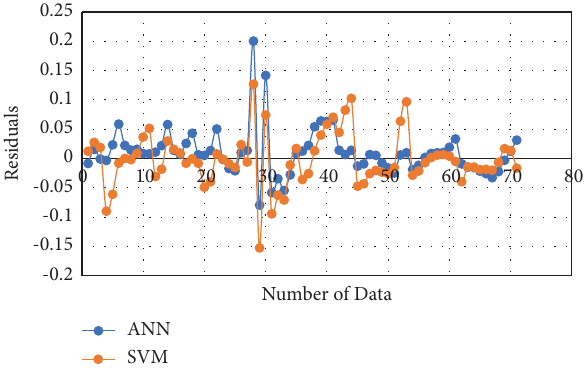
Figure 12: Residual distributions for ANN and SVM models for predicting δ